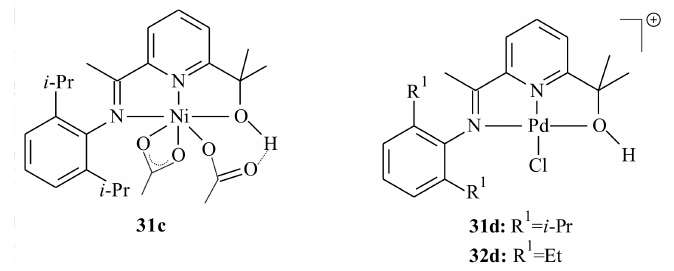
Figure 8. Structural differences between (imino)pyridinyl alcoholato Ni and Pd